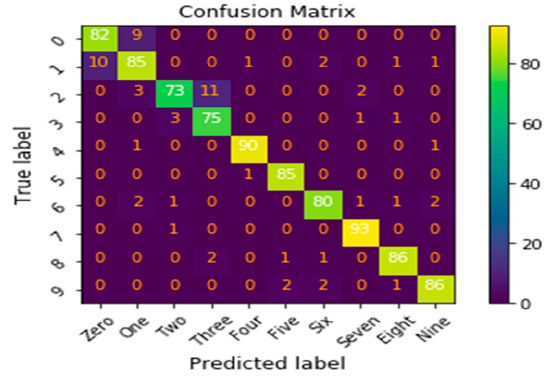
Figure 7. Confusion matrix of RNM–CNN on the CMATERDB dataset.